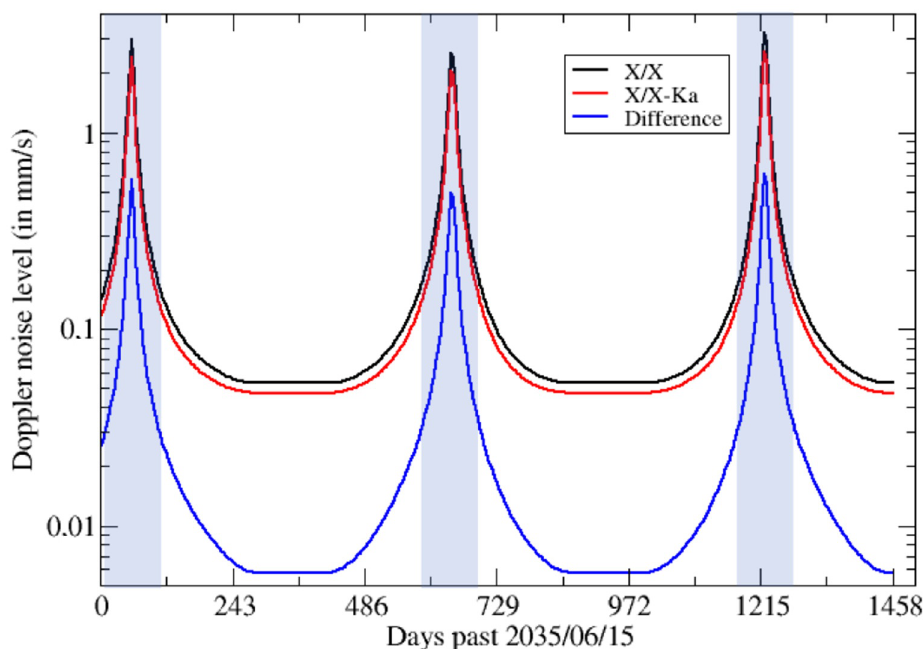
Figure A1. EnVision end-to-end two-way Doppler noise budget (10 s Doppler count time) over Venus’ six cycles of the mission science phase (1458 Earth’s days) for an X/X-Ka vs. X/X radio-link. The difference between the two link noise levels provides the gain of the Ka downlink frequency on the Doppler noise budget. The light blue areas show the three solar superior conjunction periods occurring during the science phase duration.